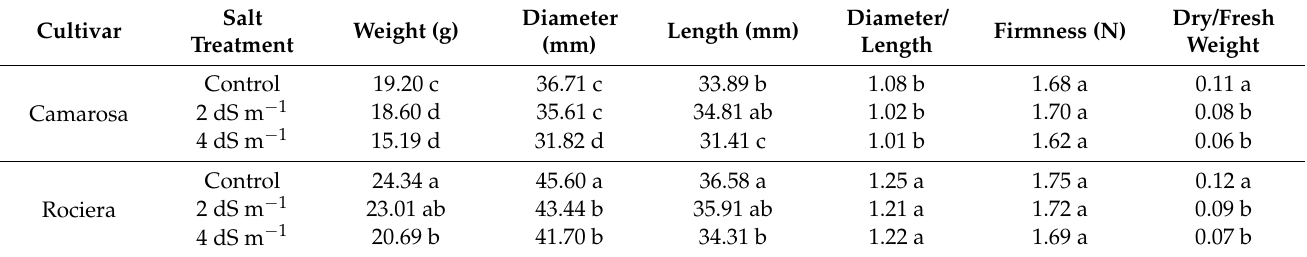
Table 3. Effect of salt stress on strawberry fruit mean weight, diameter, length, diameter:length ratio, firmness and dry:fresh weight ratio.